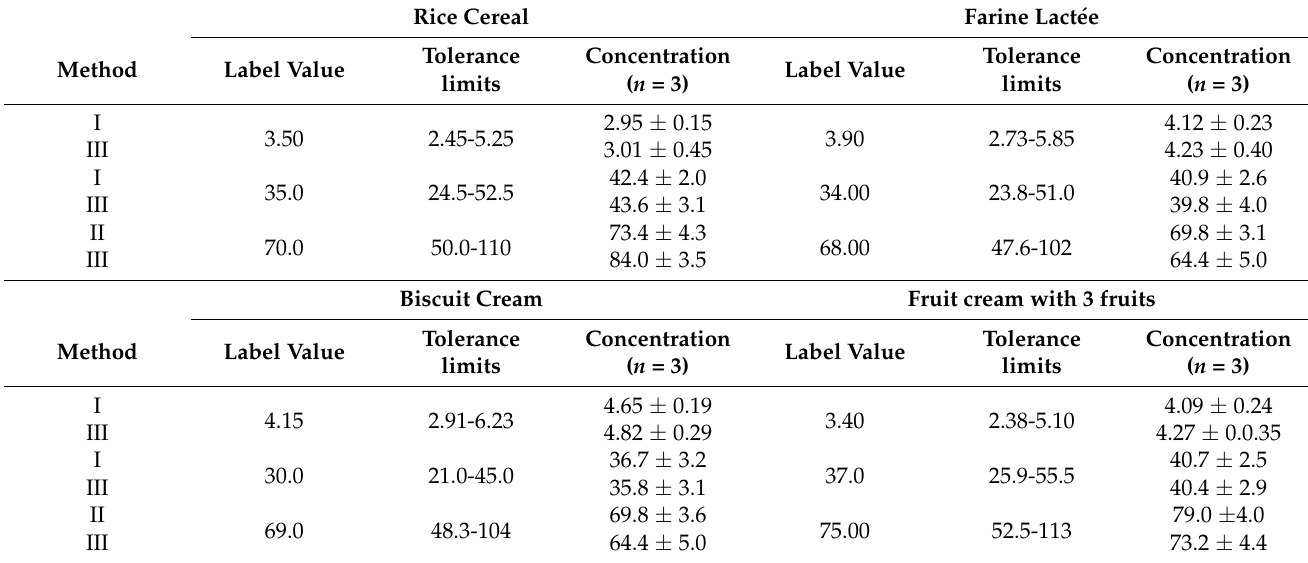
Table 12. Quantitative results of the determination of vitamins in commercial samples.